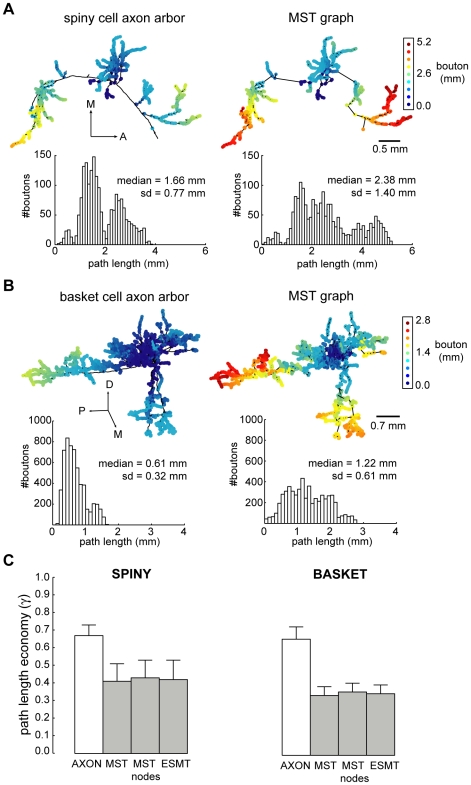
Path length economy of neocortical axons was suboptimal though superior to wire-minimized arbors.(A) Coronal view of example spiny cell axon arbor (left) and its MST (right): upper, shows wire length minimization generally increased path length from parent cell body along arbor to each bouton (dot colour codes for path length, see scale bar), and, lower, histograms show this results in a shift in path length distribution of these arbors from positively skewed to one more dispersed and symmetric. (Anatomical axes: A, anterior; D, dorsal; L, lateral; M, medial; P, posterior). (B) Surface view of example basket cell axon arbor (left) and its MST (right) shows, upper, a similar increase in path length (note different colour scale to (A)) compared with spiny axon arbor with wire minimization, and, lower, a spread in path length distribution. (C) Path length economy (γ) of spiny (left) and basket cells axons (right) was suboptimal (γAXON = PSTAR/PAXON, where PAXON is average path length from parent soma to each bouton in the arbor) though significantly greater than wire-minimization arbors regardless of whether or not (γMST = PSTAR/PMST) these inserted additional vertices (branch points) according to Steiner minimal tree criteria (γESMT = PSTAR/PESMT) or the actual axon bifurcations or nodes (γMSTnodes = PSTAR/PMSTnodes) were used.